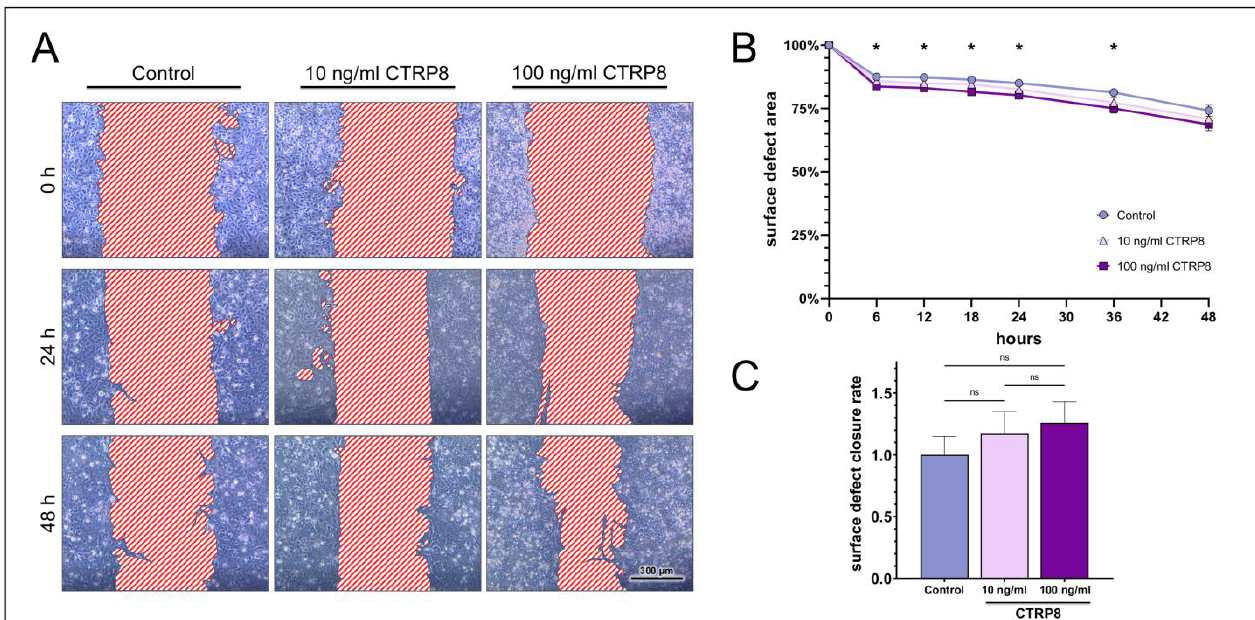
Figure 6. Scratch assays show the dose-dependent impact of CTRP8 on surface defect closure in human corneal epithelial cells (HCE). ( A ) After performing the initial scratch, HCE cells were stimulated with 0, 10, or 100 ng/mL recombinant human CTRP8 for 48 h. The surface defect was measured in a representative segment of a scratch ( n = 9) at different time points and compared to untreated cells (control). ( B ) Relative surface defect area ± SEM over time. The graph shows a significant decrease in the relative surface defect area in cells treated with 100 ng/mL CTRP8 compared to the control at 6 h but lost significance at 48 h (two-way ANOVA; * p < 0.05). Treatment with 10 ng/mL CTRP8 had no significant effect on the surface defect area when compared to the control (two-way ANOVA; p > 0.05). ( C ) Fold-increase in the surface defect closure rate. Bars represent mean ± SEM. 10 ng/mL and 100 ng/mL CTRP8 increased the relative surface defect closure rate compared to the control but not significantly (one-way ANOVA; ns = not significant, > 0.05). The difference in the surface defect closure rate between HCE cells treated with 10 ng/mL and 100 ng/mL CTRP8 was also not significant (one-way ANOVA; ns = not significant, p > 0.05).